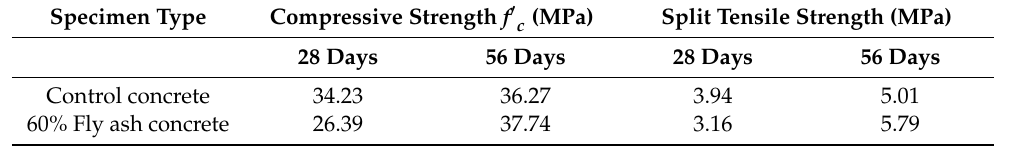
Table 2. Strength of Concrete.